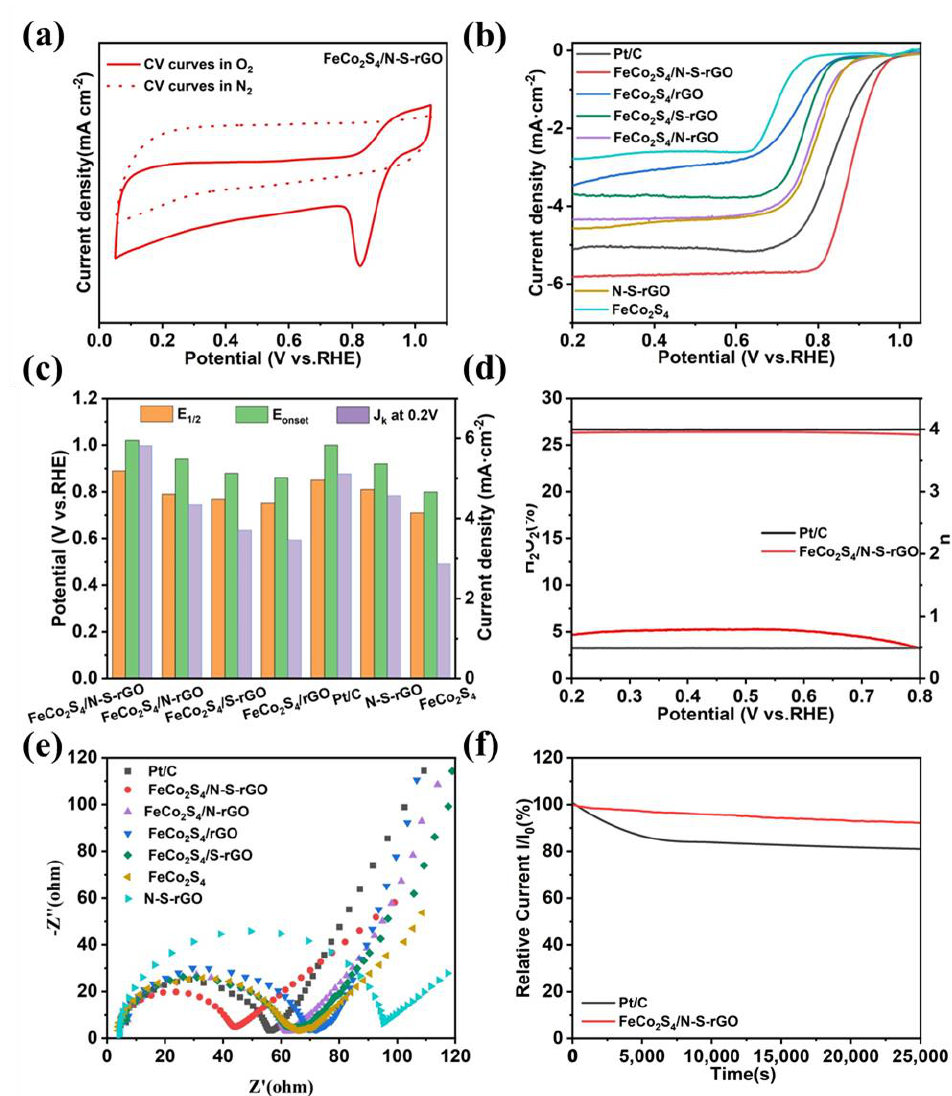
Figure 3. ( a ) CV curves of FeCo 2 S 4 /N-S-rGO in N 2 and O 2 saturated 0.1 M KOH; ( b ) LSV curves of as-prepared catalysts at 1600 rpm in 0.1 M KOH; ( c ) E 1/2 , E onset and J L at 0.2 V of catalysts; ( d ) electron transfer number (n) and H 2 O 2 yield of Pt/C and FeCo 2 S 4 /N-S-rGO; ( e ) the electrochemical impedance spectroscopy (EIS) of different catalysts; ( f ) timing current tests (i – t) for Pt/C and FeCo 2 S 4 /N-S-rGO.